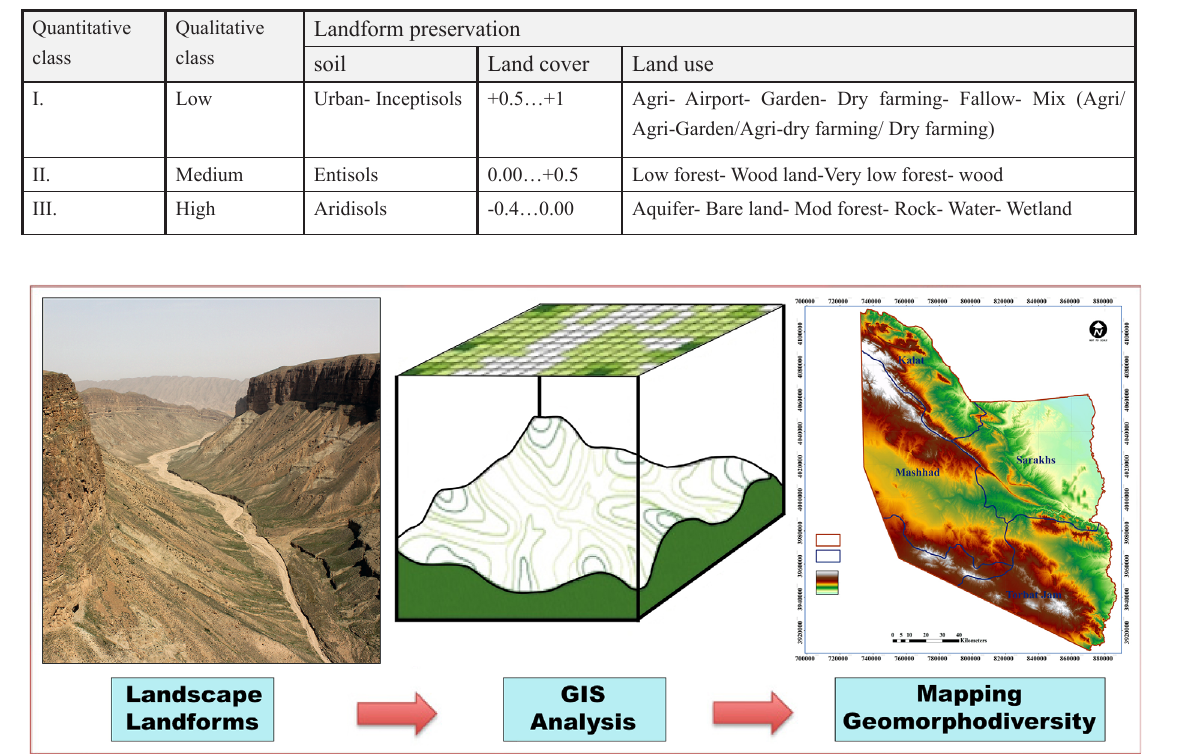
Table 2. How to score and classify the sub-criteria used in the protection